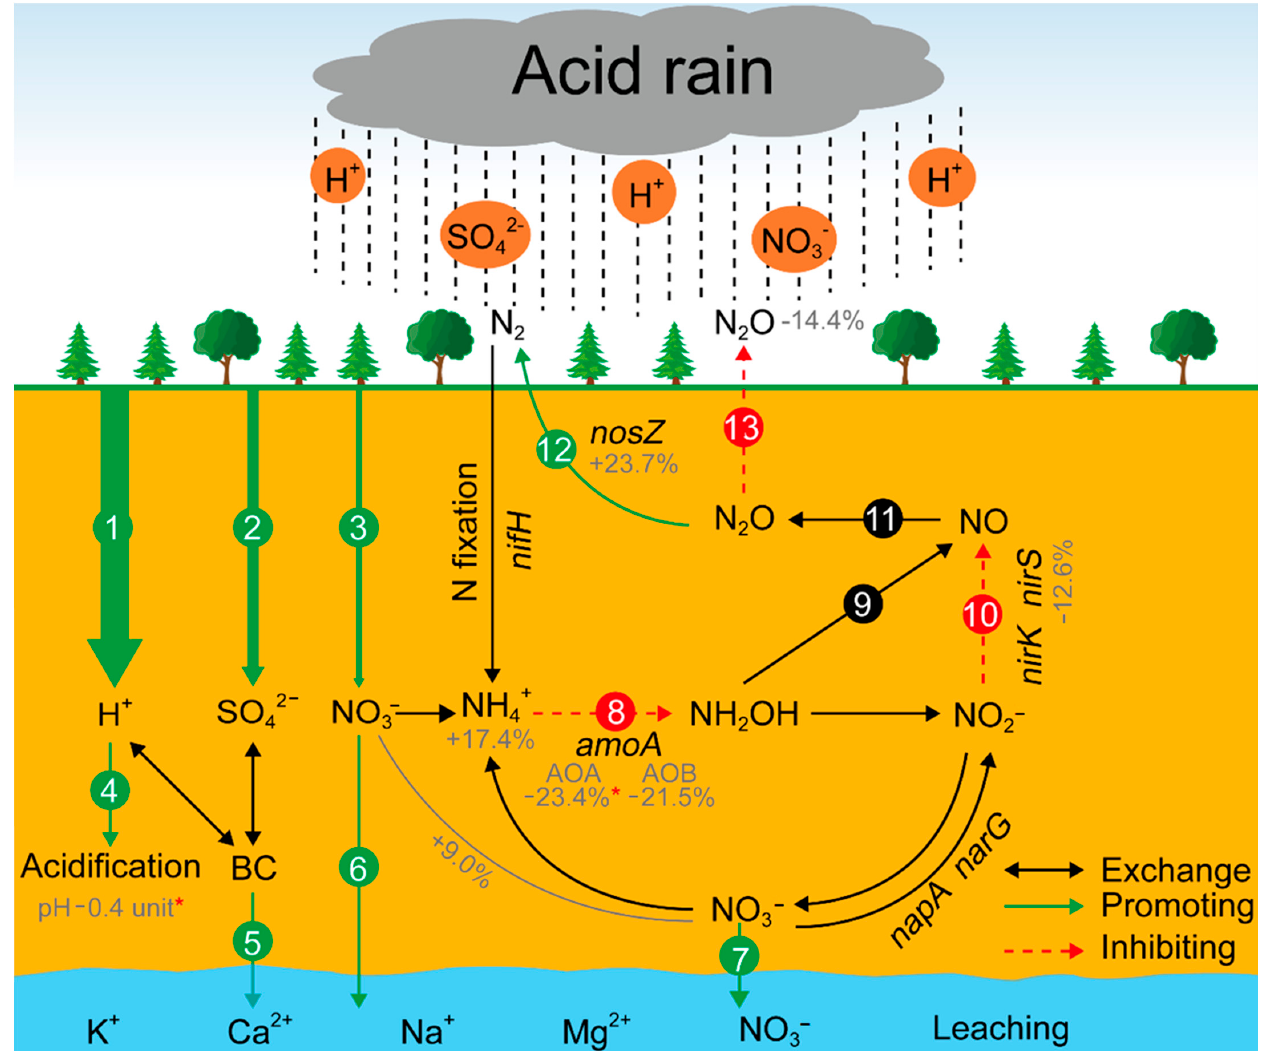
Figure 5. Predicted model showing the changes in N 2 O flux under continuing acid rain based on the previous established N cycle paths [21]. (1), (2), and (3) H + , SO 42 − , and NO 3 − inputs carried by acid rain; (4) soil acidification by H + input; (5) BC (base cations) leaching; (6) and (7) NO 3- leaching; (8) ammonia oxidation (from NH 3 to hydroxylamine); (9) nitrifier denitrification; (10) nitrite reduction; (11) NO reduction; (12) the reduction of N 2 O to N 2 ; and (13) soil N 2 O emissions. The percentages under soil nutrients and functional genes correspond to the changes in soil parameters and OTUs number in our study. * p < 0.05. Two-way arrows indicate the ions exchange. Green and red arrows represent the predicted positive and negative changes with continuous acid rain input, respectively.